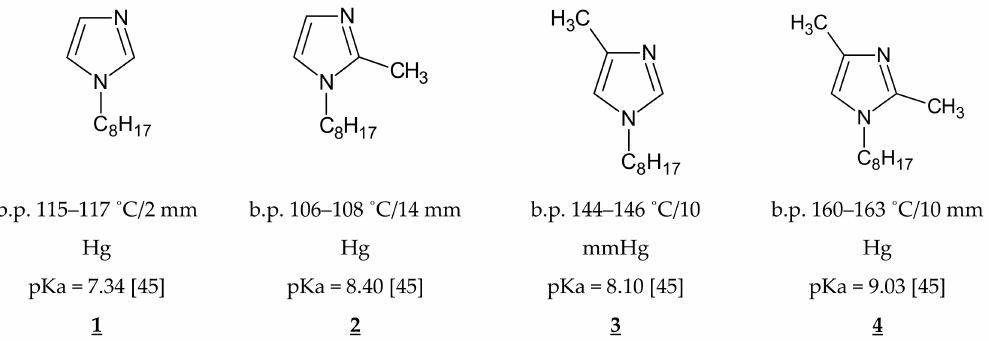
Figure 1. The chemical formula of